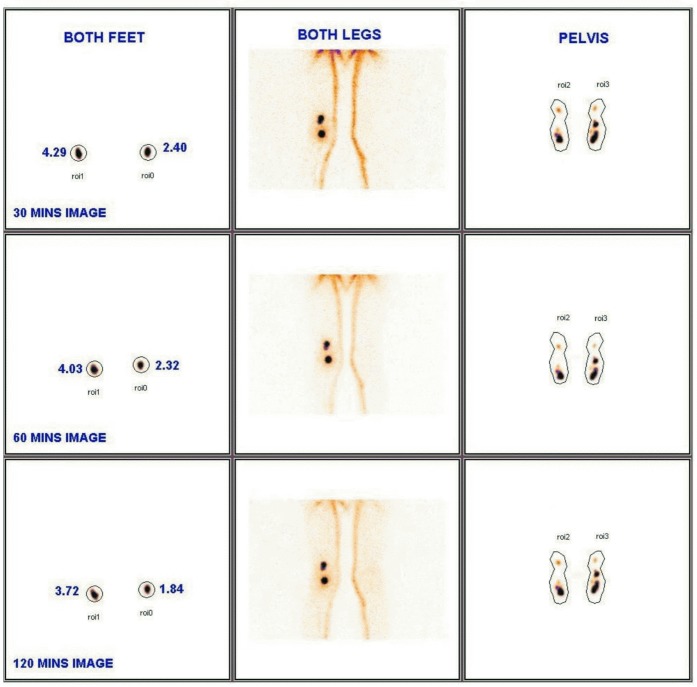
Baseline 30, 60, & 120 minute images of lymphoscintigraphy in a 8 year old male (asymptomatic and Mf positive).Images show visualization of popliteal nodes and fewer inguinal nodes on right leg indicating tracer accumulation at popliteal level hence lymphatic flow obstruction.There is also delayed clearance from the injection site on the right foot.